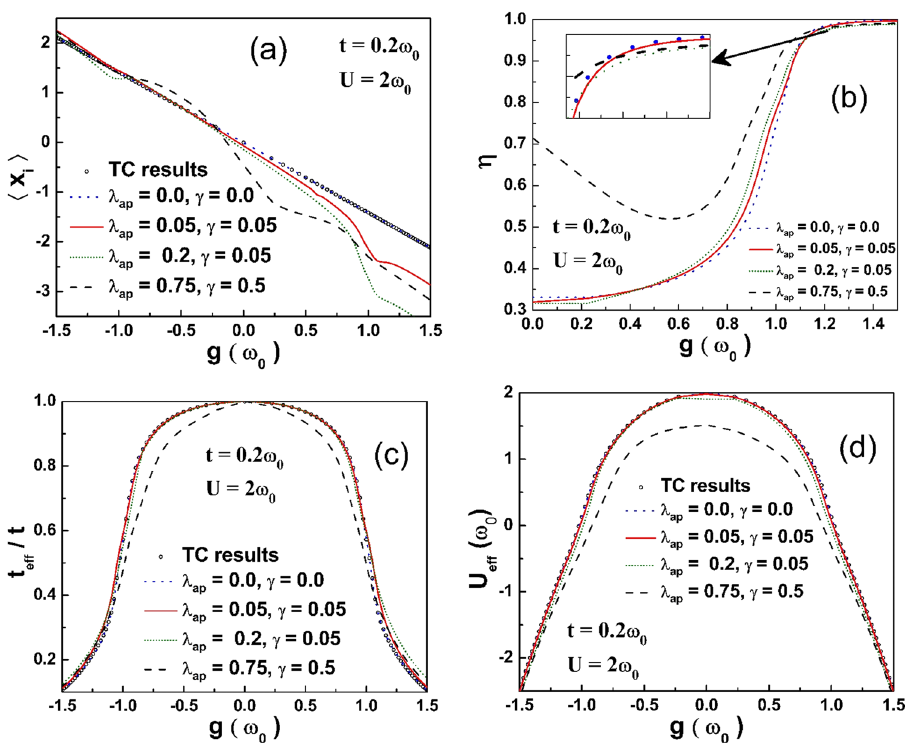
Figure 2. ( a ) 〈 x i 〉 as a function of g for different values of λ ap and γ . ( b ) η vs. g . ( c ) t eff / t as a function of g . ( d ) U eff as a function of g